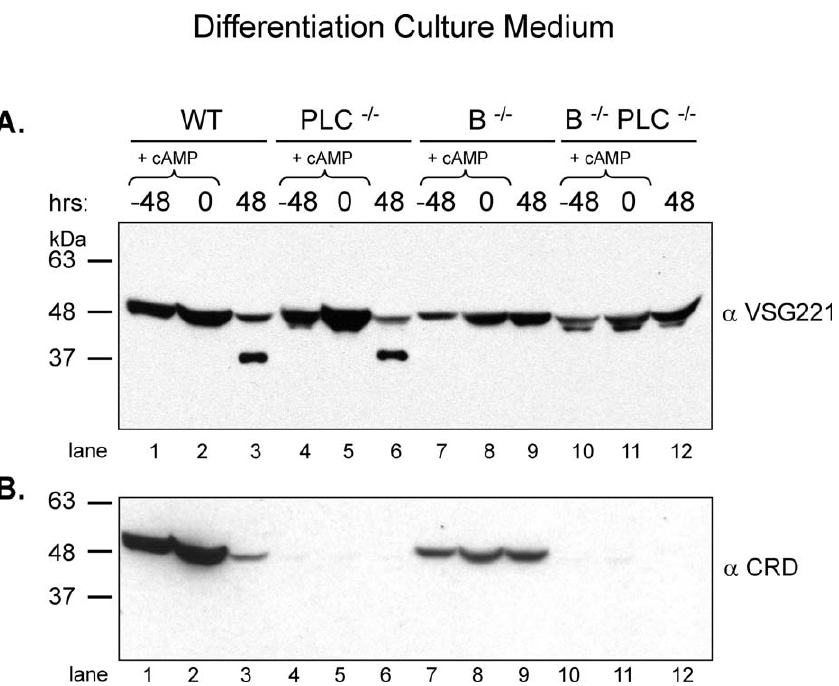
Figure 8. Released VSG221 Protein Occurs in the Culture Medium of BSF Cells and BSF-to-PRO Differentiating Cells Cultured logarithmic WT and gene-deleted BSF cells were subjected to centrifugation and supernatants were collected prior to pCPTcAMP (cAMP) addition ( (cid:2) 48), prior to resuspension of cells in PRO medium (0) and 48 h after differentiation was initiated. Aliquots of the supernatants were probed in western blots with (A) antiserum against VSG221 ( a VSG221) and (B) then stripped and reprobed with antiserum against the cross-reactive determinant ( a CRD) found on GPI-anchored proteins hydrolyzed by